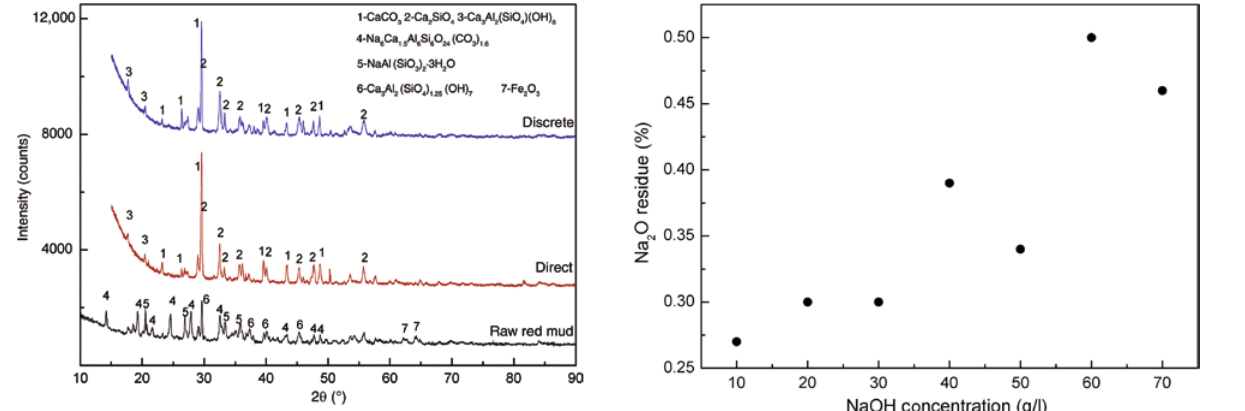
O content in calcified residues using NaOH solutions of Figure 5: Na 2 different